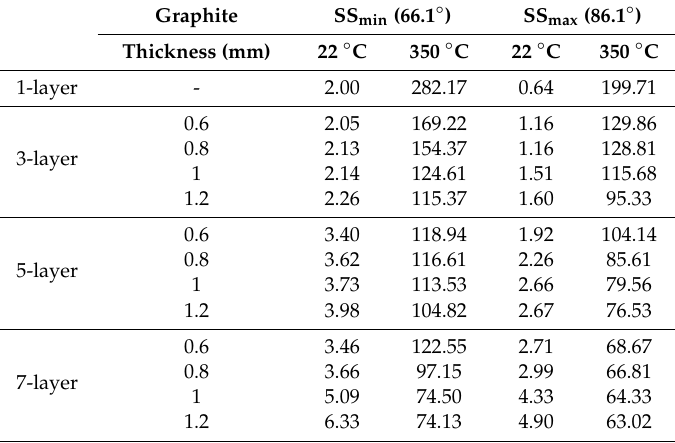
Table 5. Maximum contact stresses of stainless steel.